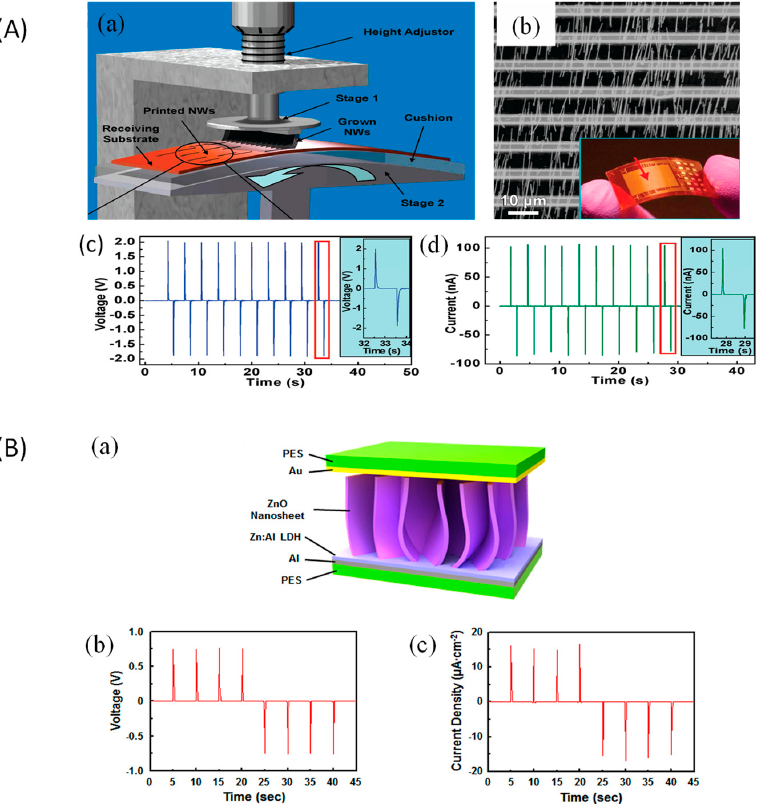
Figure 3. ( A ) Fabrication and characterization of the HONG device. ( a ) Schematics of the experimental setup used for transferring the vertically aligned ZnO nanowire onto a flexible substrate by changing their alignment to horizontal. ( b ) SEM image of horizontally aligned ZnO nanowire with an Au electrode printed on it (sputtering). Inset: actual photograph of the fabricated device. ( c ) Open-circuit voltage of HONG. ( d ) Short-circuit current of HONG. Both ( c , d ) were obtained under 0.1% strain, at a 5% s - 1 strain rate, with a deformation frequency of 0.33Hz. The enlarged view of the red box was shown in the inset. The inset shows an enlarged view of deformation cycles. Reprinted with permission from [14]. Adapted with permission from Zhu et al. (2010). Copyright © 2010 American Chemical Society. ( B ) Two-dimensional nanosheets/ionic layer heterojunction-based PENG. ( a ) Schematics of 2D nanosheet-based PENG, with 2D nanosheets and an anionic nanoclay layer heterojunction. ( b , c ) depict the output voltage and output current density, respectively, in the switching-polarity test at 4 KgF [18]. Adapted with permission from Kim et al. (2013). Copyright © 2013 Nature